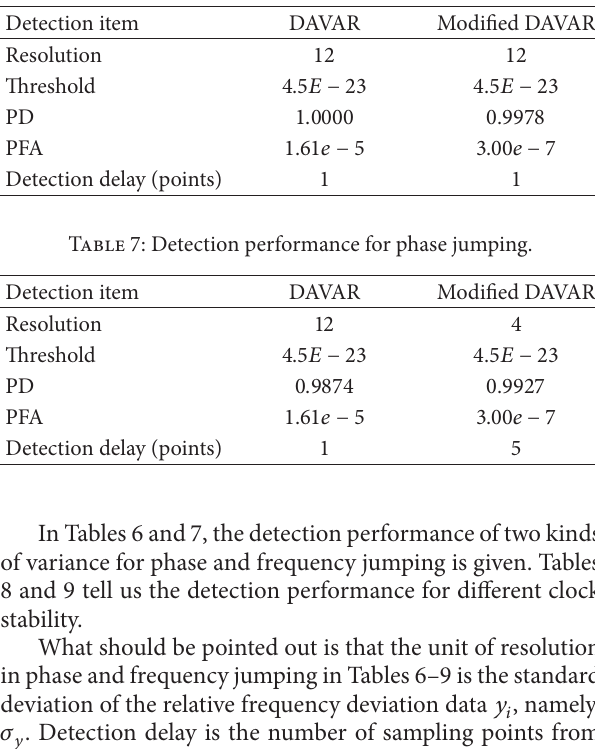
Table 6: Detection performance for phase jumping.